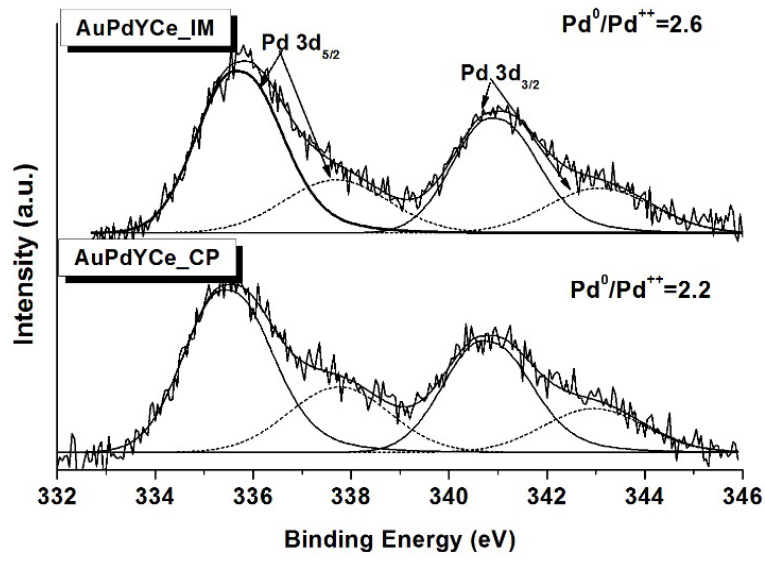
room Figure 5. Pd 3d XP spectra of Pd–AuYCeIM and Pd–AuYCeCP catalysts after hydrogen treatment at room temperature.